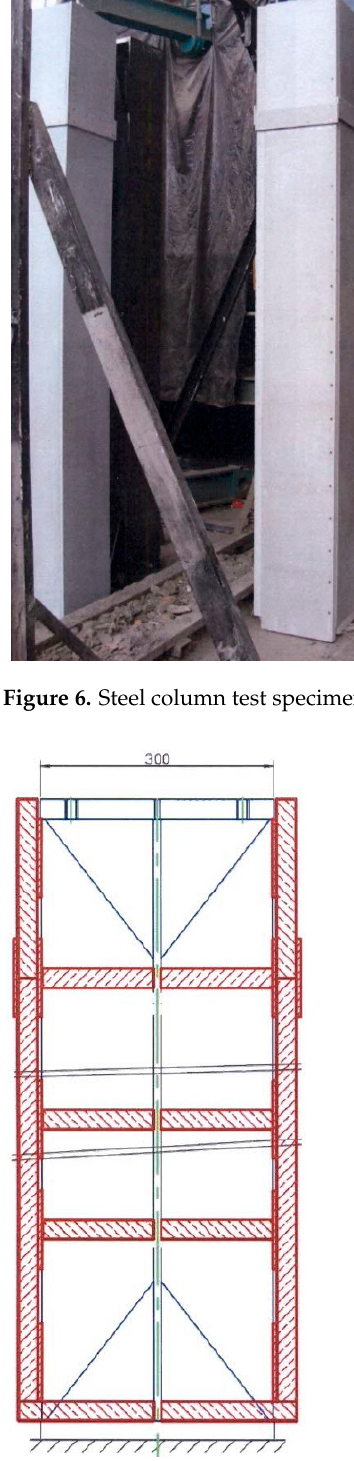
Figure 7. Assembly pattern of the fire protection cladding.